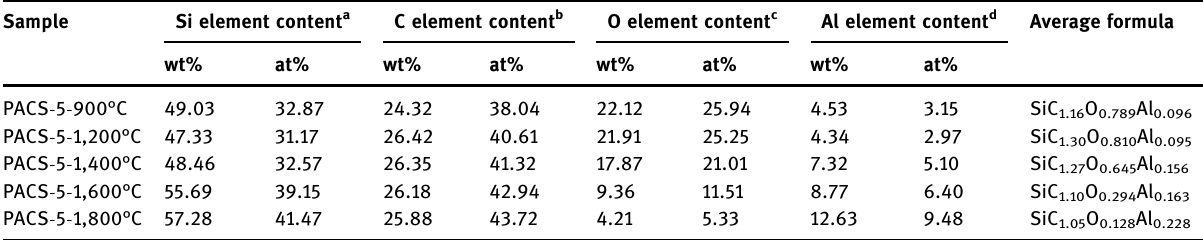
Table 1: Chemical composition of the 1,600°C ceramics from bulk chemical analysis Sample